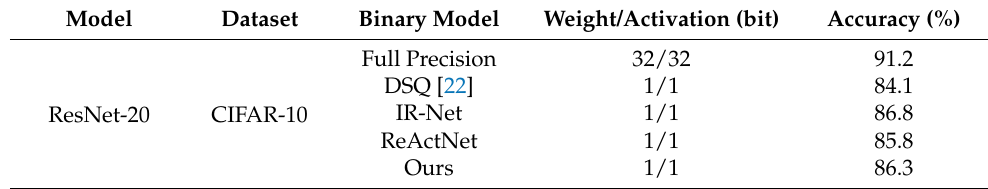
Table 3. Accuracy of binarized ResNet-20 was evaluated using the CIFAR-10 data set.